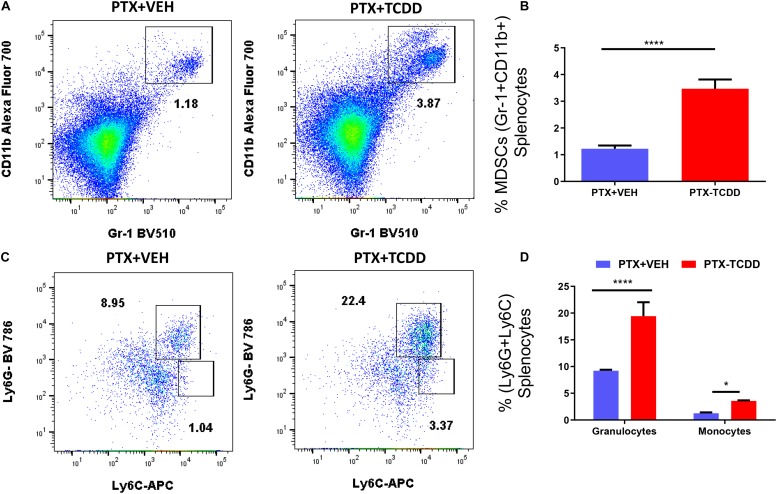
TCDD induces MDSCs: Mice were immunized with PTX and injected with TCDD as described in the legend of Figure 1. Spleen cells were double-stained for Gr-1+CD11b+ cells to determine MDSC percentages. Panel A shows a representative experiment while data from multiple experiments are plotted in panel B. Percentages of MDSC subsets (granulocytic, CD11b+Ly6G+, and monocytic, CD11b+Ly6C+) were also determined, with representative data presented in panel C and data from multiple experiments represented in panel D. Statistical analysis was performed using a Student’s t-test. In panels C,D data are expressed as the mean ± SEM and statistical significance is indicated as ∗p < 0.05 or ****p < 0.0001 when the two groups are compared.